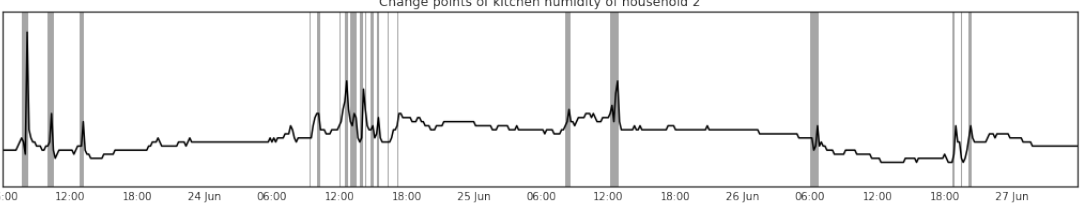
Figure 6. Change points of humidity readings from a sensor box in the kitchen of Household